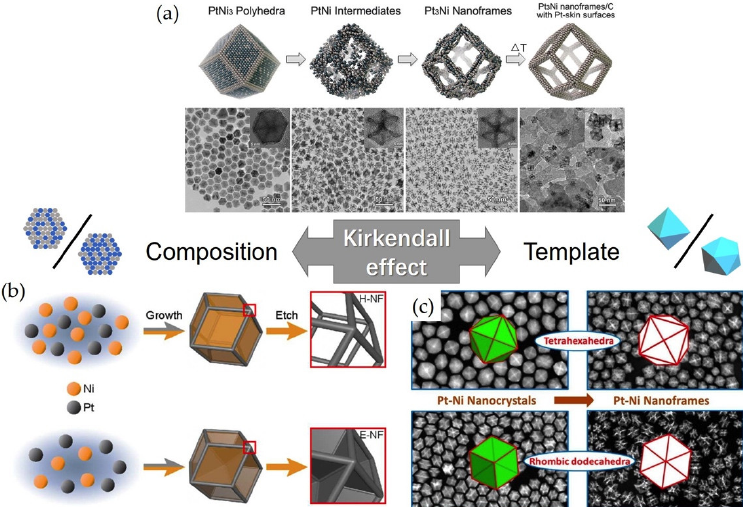
Figure 3. Evolution process from polyhedra to nanoframes exploit Kirkendall effect. Two key factors determine the final morphology in exploiting Kirkendall effect: composition and